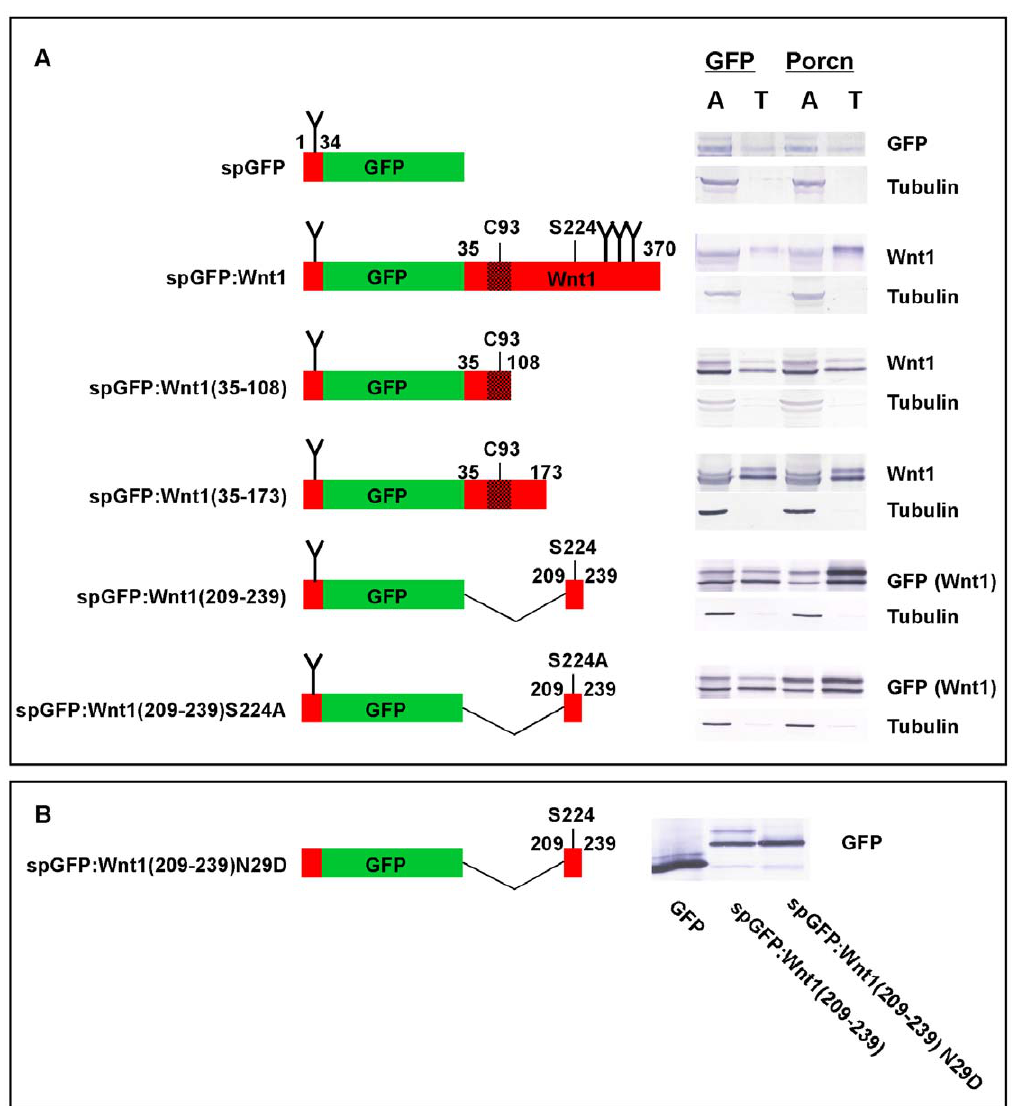
Figure 9. Porcn overexpression increases the hydrophobicity of spGFP:Wnt1(209–239), but not spGFP:Wnt1(35–108) in the TX-114 assay. Panel A: 293T cells were transfected with spGFP-tagged peptides in the presence of GFP (control) or mPorcD. A diagram of tested spGFP:Wnt1 fusions is shown on the left. Wnt1 sequences are indicated in red while GFP sequences are indicated in green. Indicated numbers correspond to the residue position in full-length Wnt1. Consensus sites for the addition of N-linked carbohydrates are shown by a ‘‘Y’’. The stippled region surrounding C93 indicates the antigen that was used to raise our monoclonal antibodies against Wnt1. Cells were incubated overnight, lysed, and extracted with TX-114 before analysis by SDS-PAGE/Western blot. spGFP:Wnt1 fusions were detected with either Wnt1 or GFP antibodies. Blotting with ß-tubulin antibodies served as a control for the extraction as we have previously shown that ß-tubulin preferentially partitions to the aqueous phase. When co-transfected with GFP, all of the fusion proteins are found in both aqueous (A) and detergent/Triton X-114 (T) phases. The presence of ectopic Porcn promotes the partitioning of spGFP:Wnt1, spGFP:Wnt1 (209–239), and spGFP:Wnt1 (209–239) S224A, but not spGFP:Wnt1 (35–108) or spGFP:Wnt1 (35–173) into the hydrophobic phase, indicating that 1) Porcn promotes the hydrophobic modification of a 31 residue peptide containing S224 2) that at least one additional site for the modification of Wnt by Porcn is likely to exist within the 31 residue peptide. These experiments were performed four times, on average. Panel B: A Western blot of cell lysates isolated from HEK293T cells transiently transfect with constructs encoding GFP, spGFP:Wnt1(209–239), and spGFP:wnt1(209–239) N29D is shown. The blot was probed with anti-GFP antibodies.